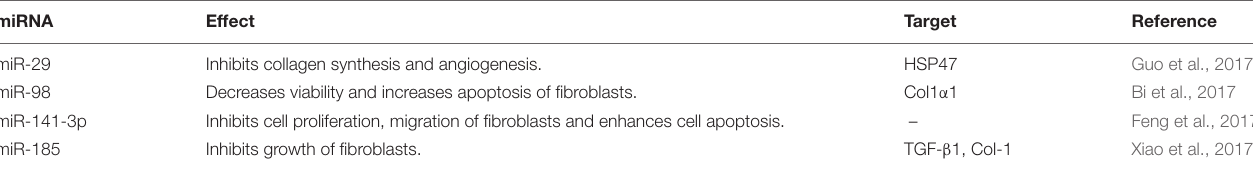
TABLE 3 | miRNAs involved in granulation tissue formation in wound healing.